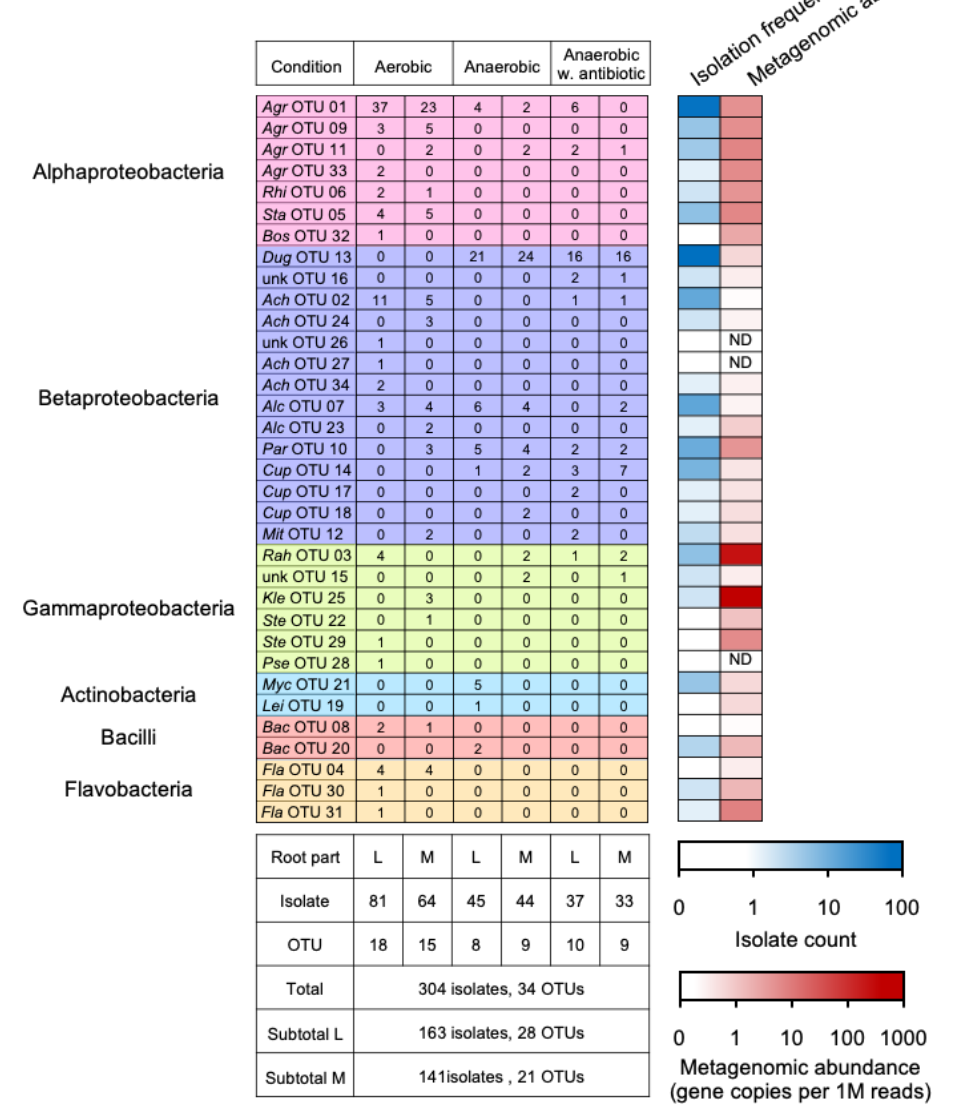
Figure 3. Bacterial isolates with potential denitrification functions from the Miscanthus rhizosphere. The upper-left table shows the distribution of OTUs, which were defined using amplified ribosomal DNA restriction analysis (ARDRA). The blue and red heatmaps show the isolate numbers and rhizospheric abundances of the OTUs, respectively. The lower-left table shows the numbers of bacterial isolates and OTUs using different isolation strategies. Abbreviations: Agr , Agrobacterium ; Rhi , Rhizobium ; Sta , Starkeya ; Bos , Bosea ; Dug , Duganella ; Ach , Achromobacter ; Alc , Alcaligenes ; Par , Paraburkholderia ; Cup , Cupriavidus ; Mit , Mitsuaria ; Rah , Rahnella ; Kle , Klebsiella ; Ste , Stenotrophomonas ; Pse , Pseudomonas ; Myc , Mycobacterium ; Lei , Leifsonia ; Bac , Bacillus ; Fla , Flavobacterium ; unk, unknown; L, lateral roots; M, main roots; ND, not detected.